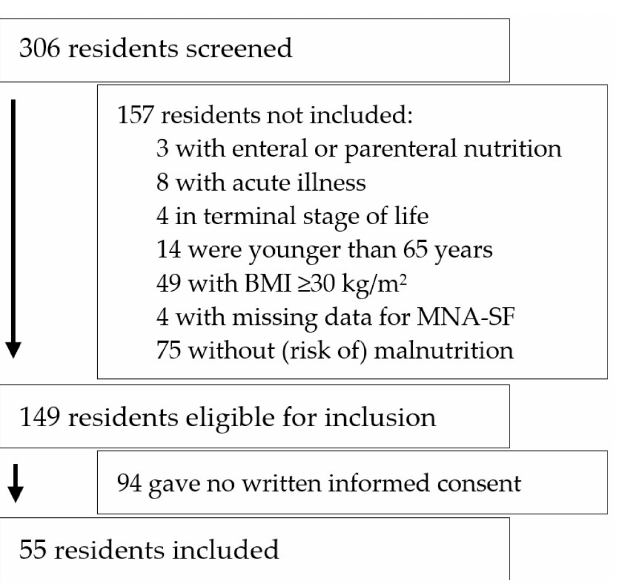
Figure 1. Flow chart of recruitment process. BMI, body mass index; MNA-SF, mini nutritional assessment-short